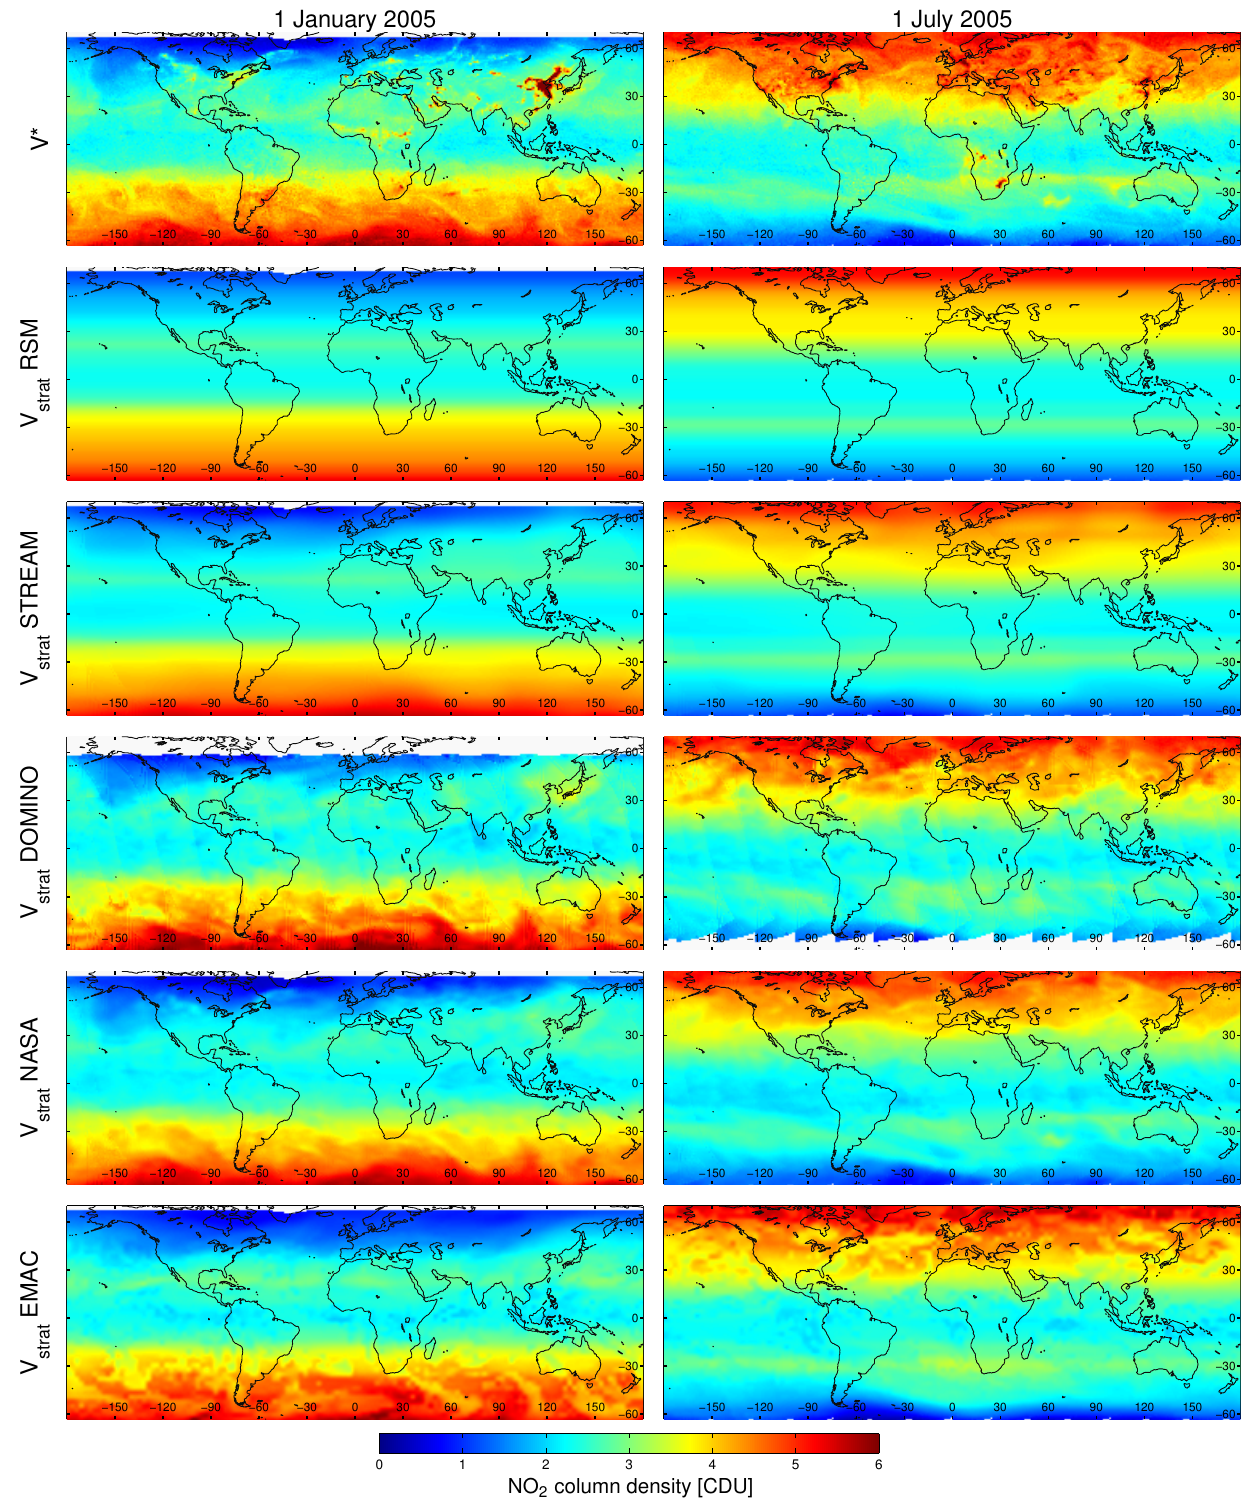
Figure 3. Total OMI VCD V ∗ (top) and the resulting stratospheric estimate V strat from RSM (second row) and STREAM (third row) for 1 January (left) and 1 July (right) 2005. Resulting V strat from other algorithms are included as well for comparison (see Sect.